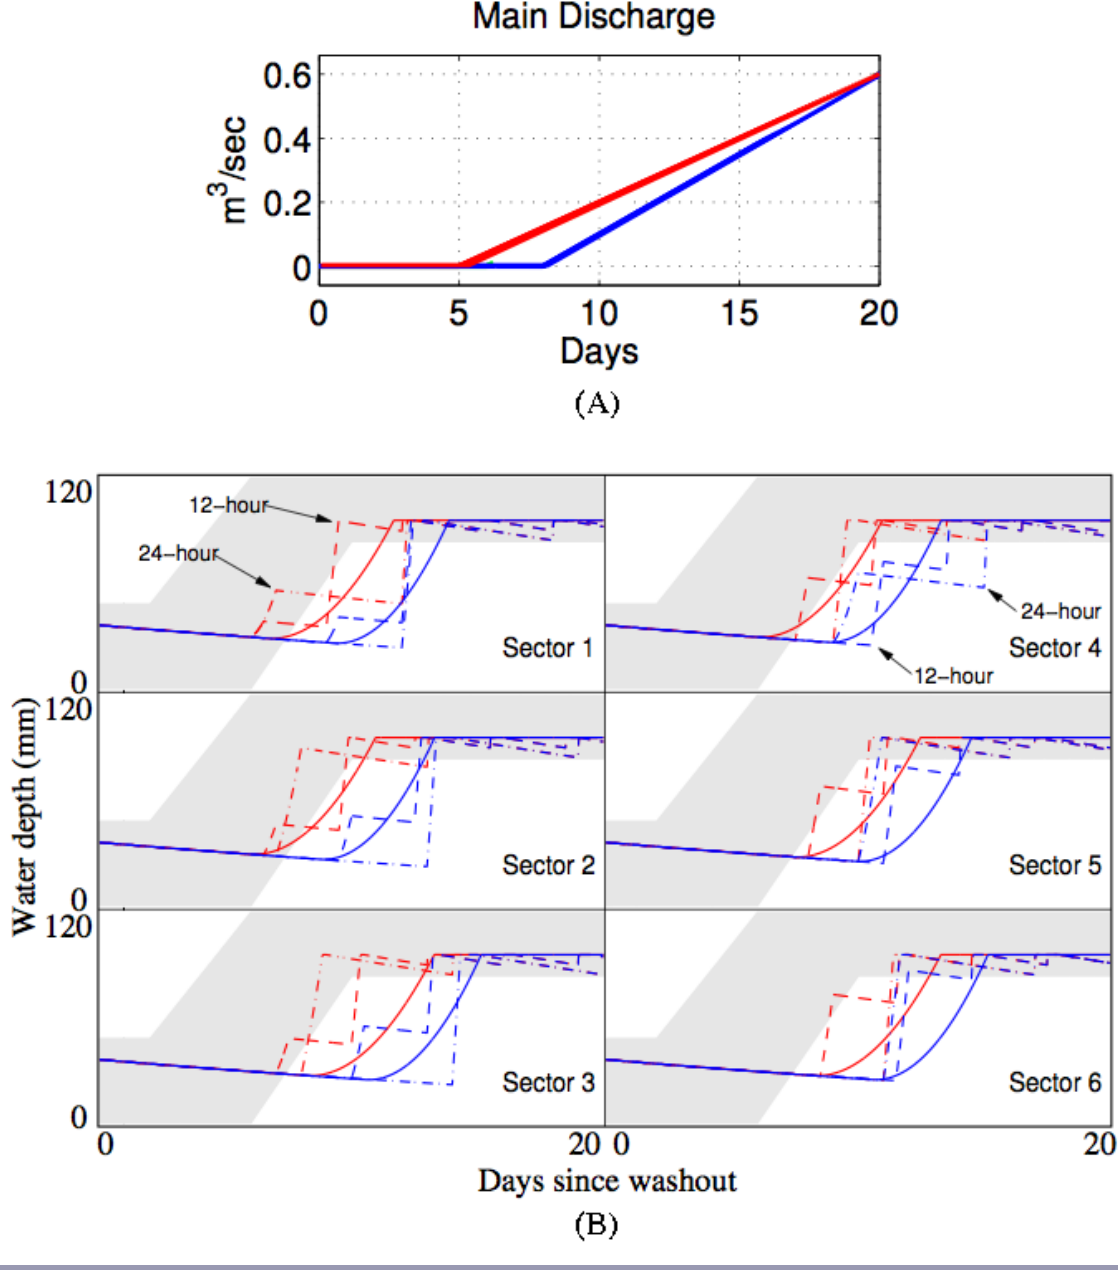
Fig. 11 . Demand vs. supply profiles after a shock to headgate infrastructure. (A) Two scenarios of water flow as repairs to headgate are made. (B) Comparisons of open flow (solid), 12-hour rotations (dashed), and 24-hour rotations (dash-dot). The color coding is as follows: Red- by the 5th day infrastructure is sufficiently repaired to allow for a portion of the water to flow into the system. Blue- it takes 8 days until infrastructure is sufficiently repaired to allow for a portion of the water to flow into the